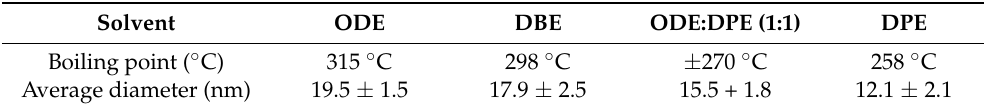
Table 2. Dependence of the average diameter of Pd/Fe-oxide NPs on the b.p. of the solvent in which the experiment was